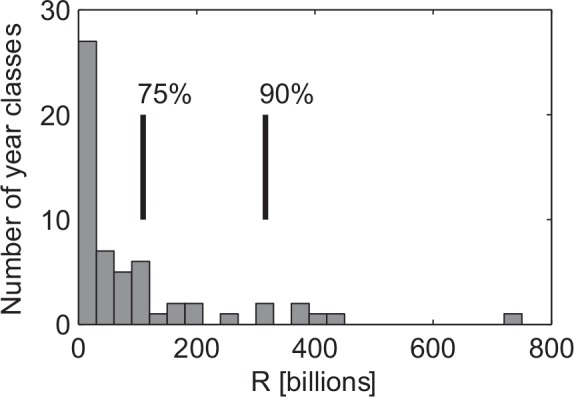
Histogram of the Norwegian Spring Spawning herring (Clupea harengus L.) recruitment during the period 1935–2010.The vertical lines are the 75th%ile and the 90th%ile.